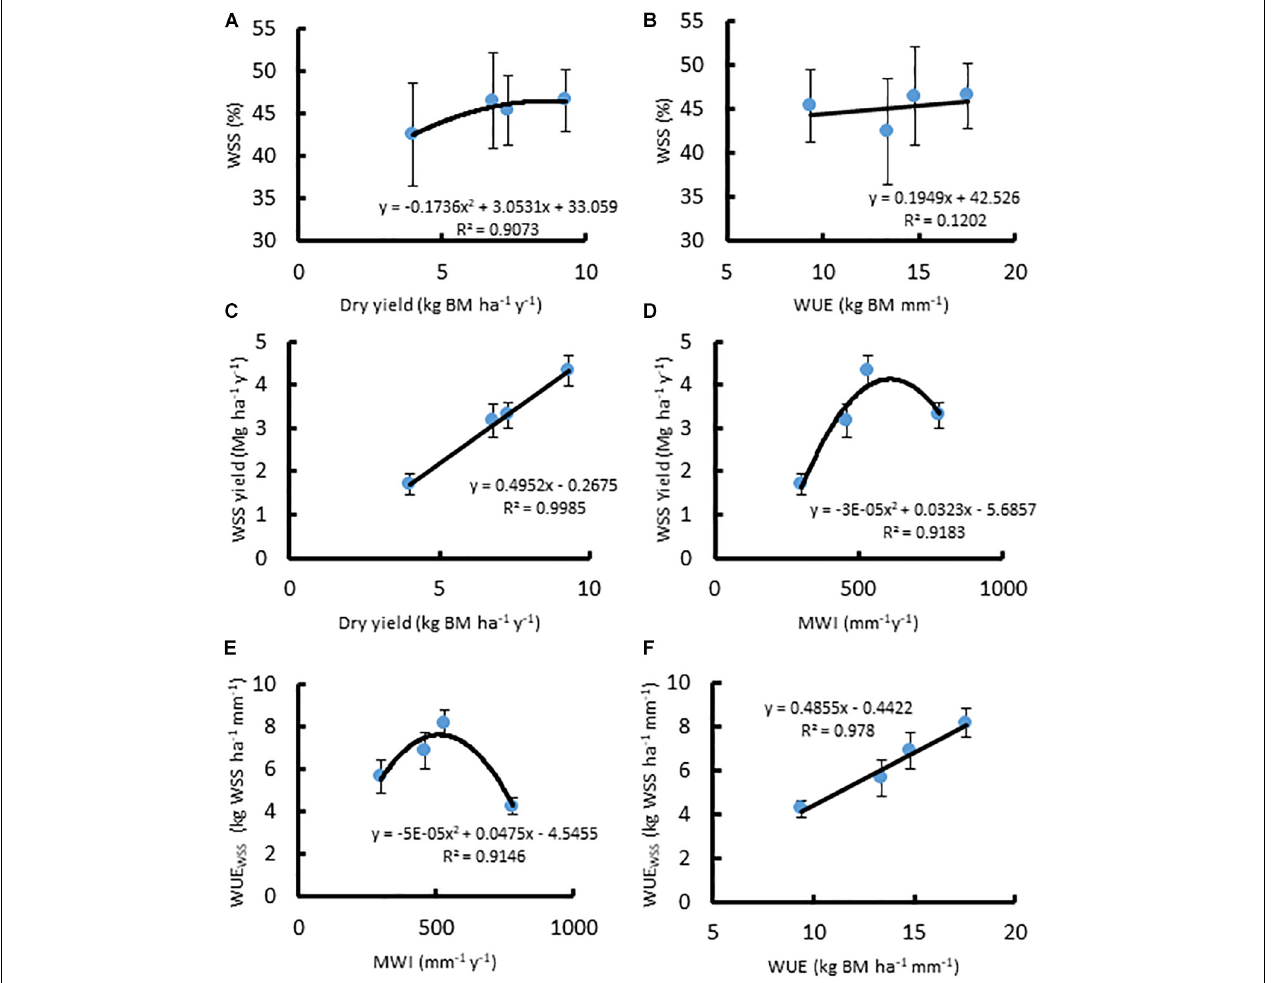
FIGURE 3 | Relationships between (A) dry biomass yield (Mg ha − 1 y − 1 ) and WSS (%), (B) WUE (kg ha − 1 mm − 1 ) and WSS (%), (C) dry biomass yield and WSS yield (Mg ha − 1 y − 1 ), (D) MWI (mm y − 1 ) and WSS yield, (E) MWI and WUE WSS (kg WSS ha − 1 mm − 1 ), and (F) WUE and WUE WSS , for A. americana . Error bars indicate standard error of the mean; n =